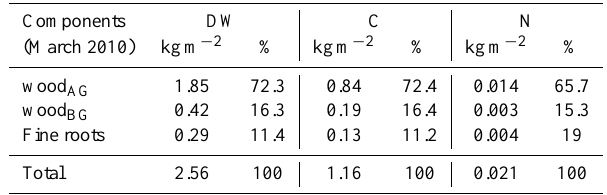
Table 2. Distribution of dry weight (DW), C and N stocks within the ecosystem at the beginning of the growing season (March 2010). wood AG includes trunks and standing branches of different age; wood BG represents coarse roots (Table 1). Fine roots were obtained by the intensive soil core sampling conducted in March 2010. Soil C and N content in the upper 60cm of soil were 21.3 ± 2.8 and 2.5 ± 0.3kgm − 2 , respectively.